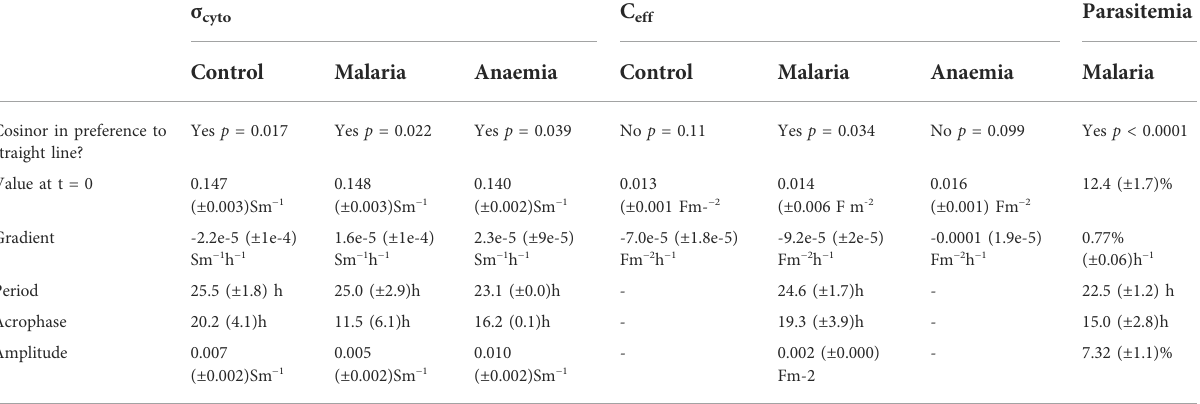
TABLE 1 The results (± standard deviation) of fi tting a damped cosinor model to the experimental data. Where the model fi ts preferentially to a straight line ( p < 0.05) the period, phase and amplitude are included, as well as the initial value and gradient of the baseline around which the sinusoid oscillates; where the straight line is preferred, the initial value and gradient are provided. σ